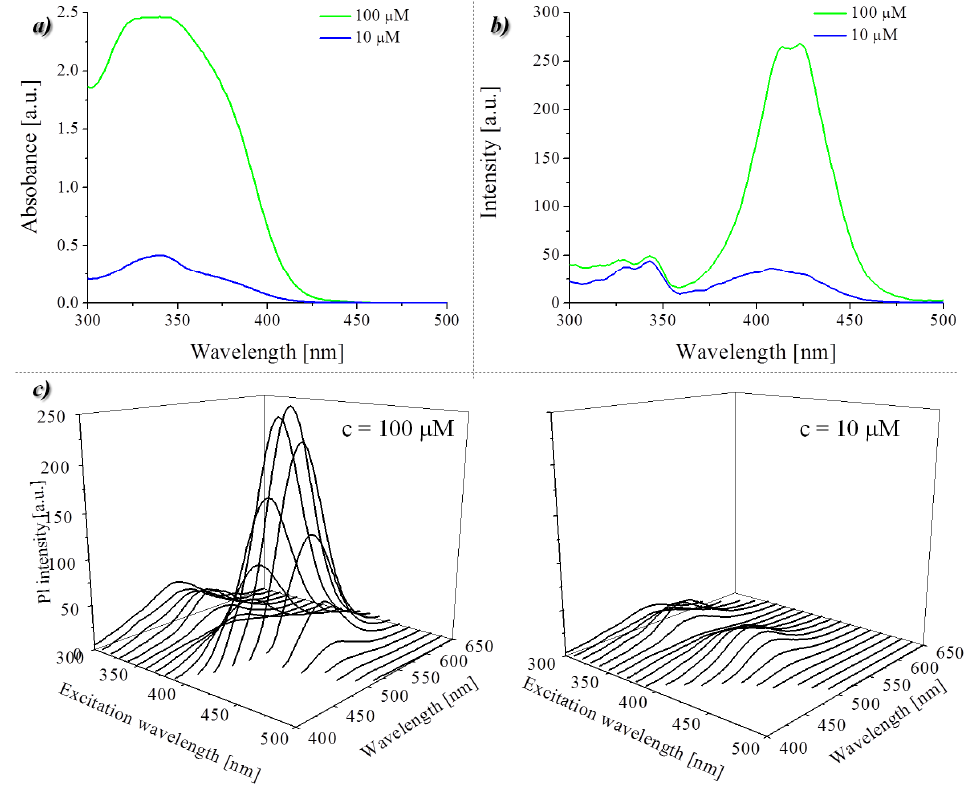
Figure 4. The ( a ) absorption, ( b ) excitation, and ( c ) 3D fluorescence spectra of AzNI-2 in chloroform solution by different concentration (c = 100, 80, 40, 20, 10, 1 μ M).